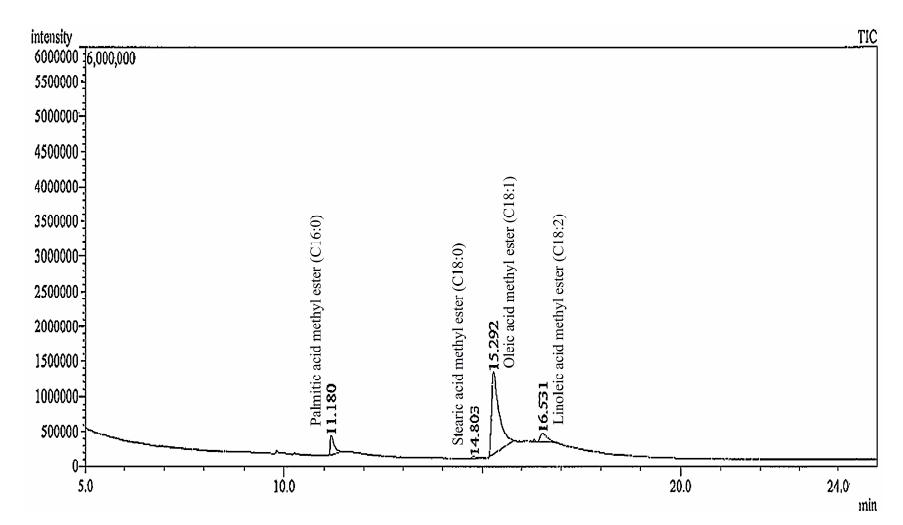
Figure 7. GC-MS chromatograms of oil extracted from membrane after performed with SEOF in the Franz cell apparatus.